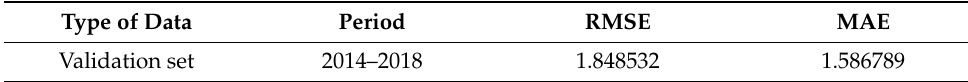
Table 6. Forecast performance of ARIMA (2, 1, 4)